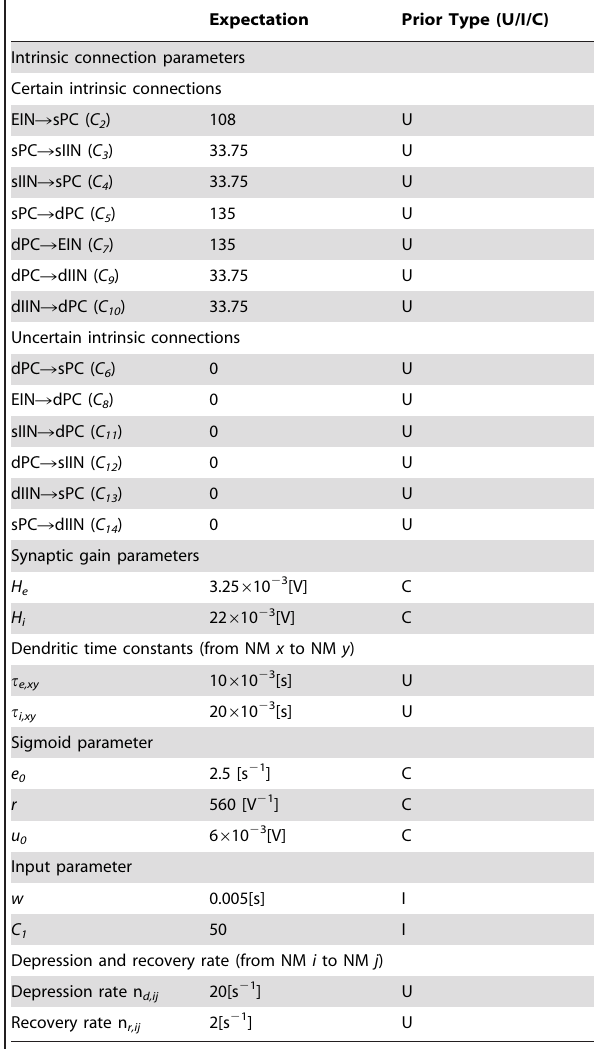
Table 1. Priors of parameters.